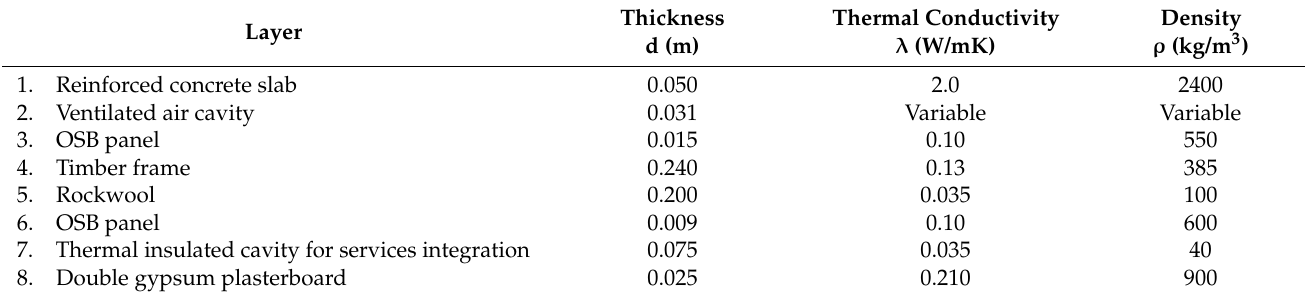
Figure 1. Horizontal section of the opaque ventilated façade module analyzed. The layers numbering refers to Table A1. Table 1. Opaque ventilated façade layers description